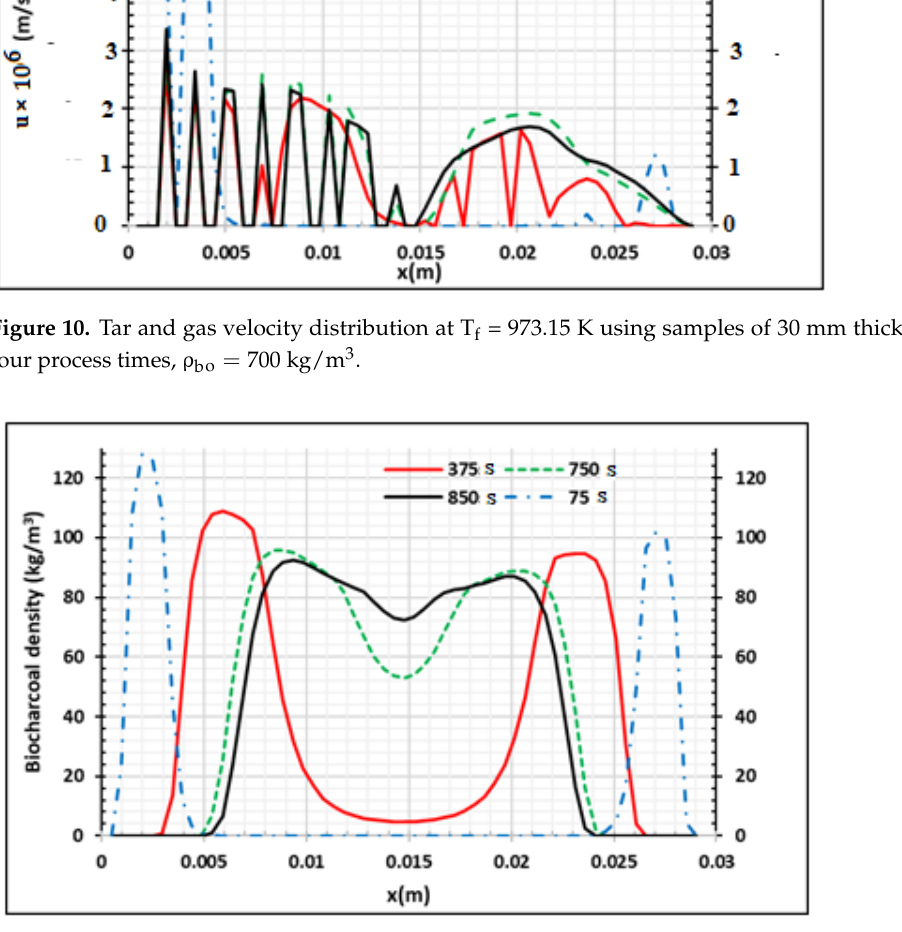
Figure 11. Production of biocharcoal density at T f = 973.15 K using samples of 30 mm thickness at four process times, ρ bo = 700 kg/m 3 .